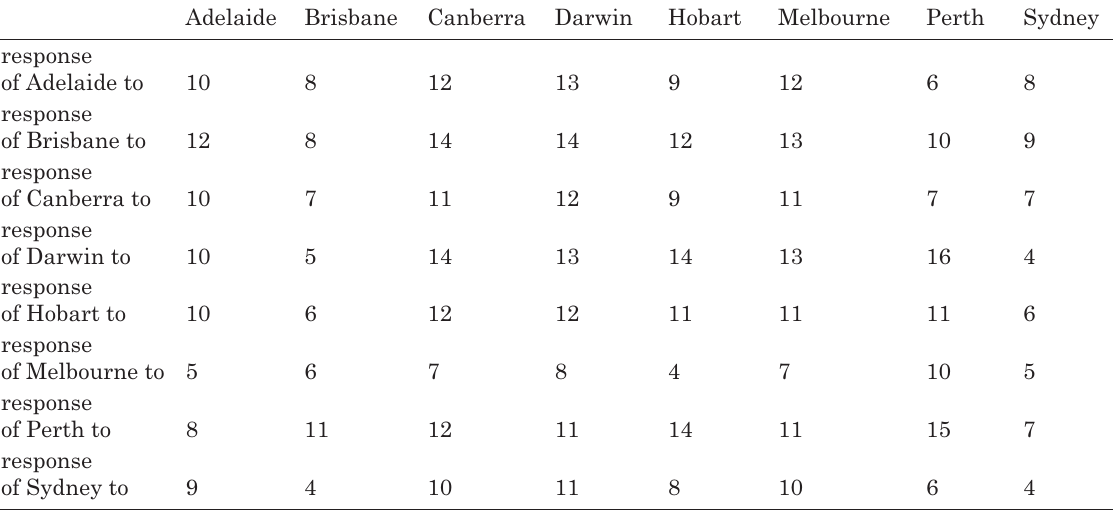
Table 5. Lagged terms when fi rst reaching a value of impulse response of less than